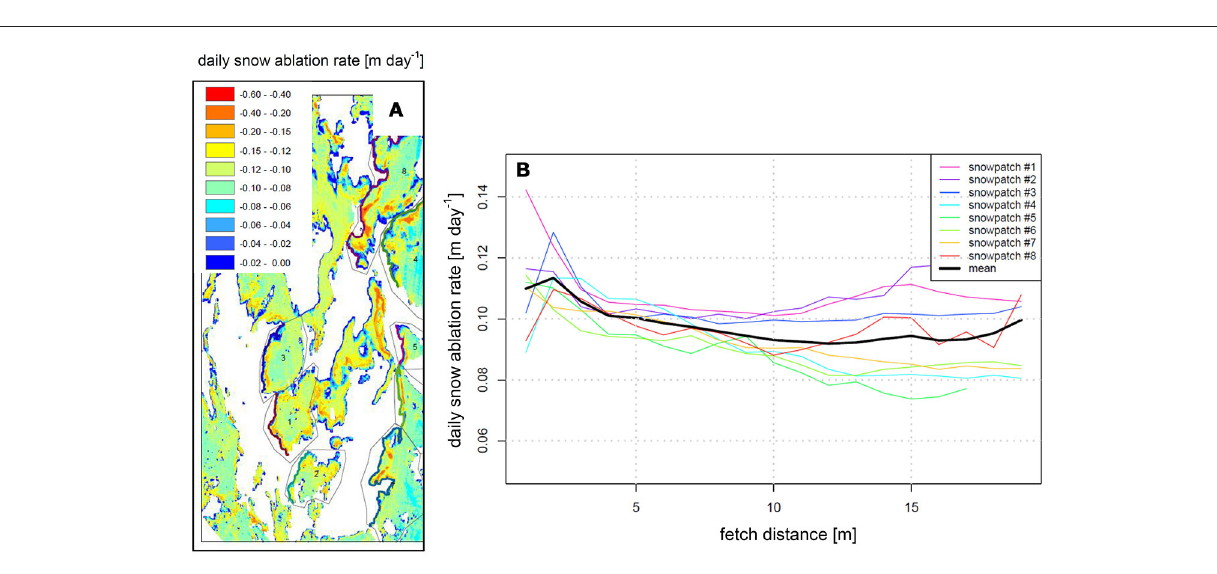
rates from the laser scanner as a function of the fetch distance exemplarily for 1 day (21 May 2014) in the late ablation period 2014 with an already patchy snow cover (SCF = 40%) ( Figure 5